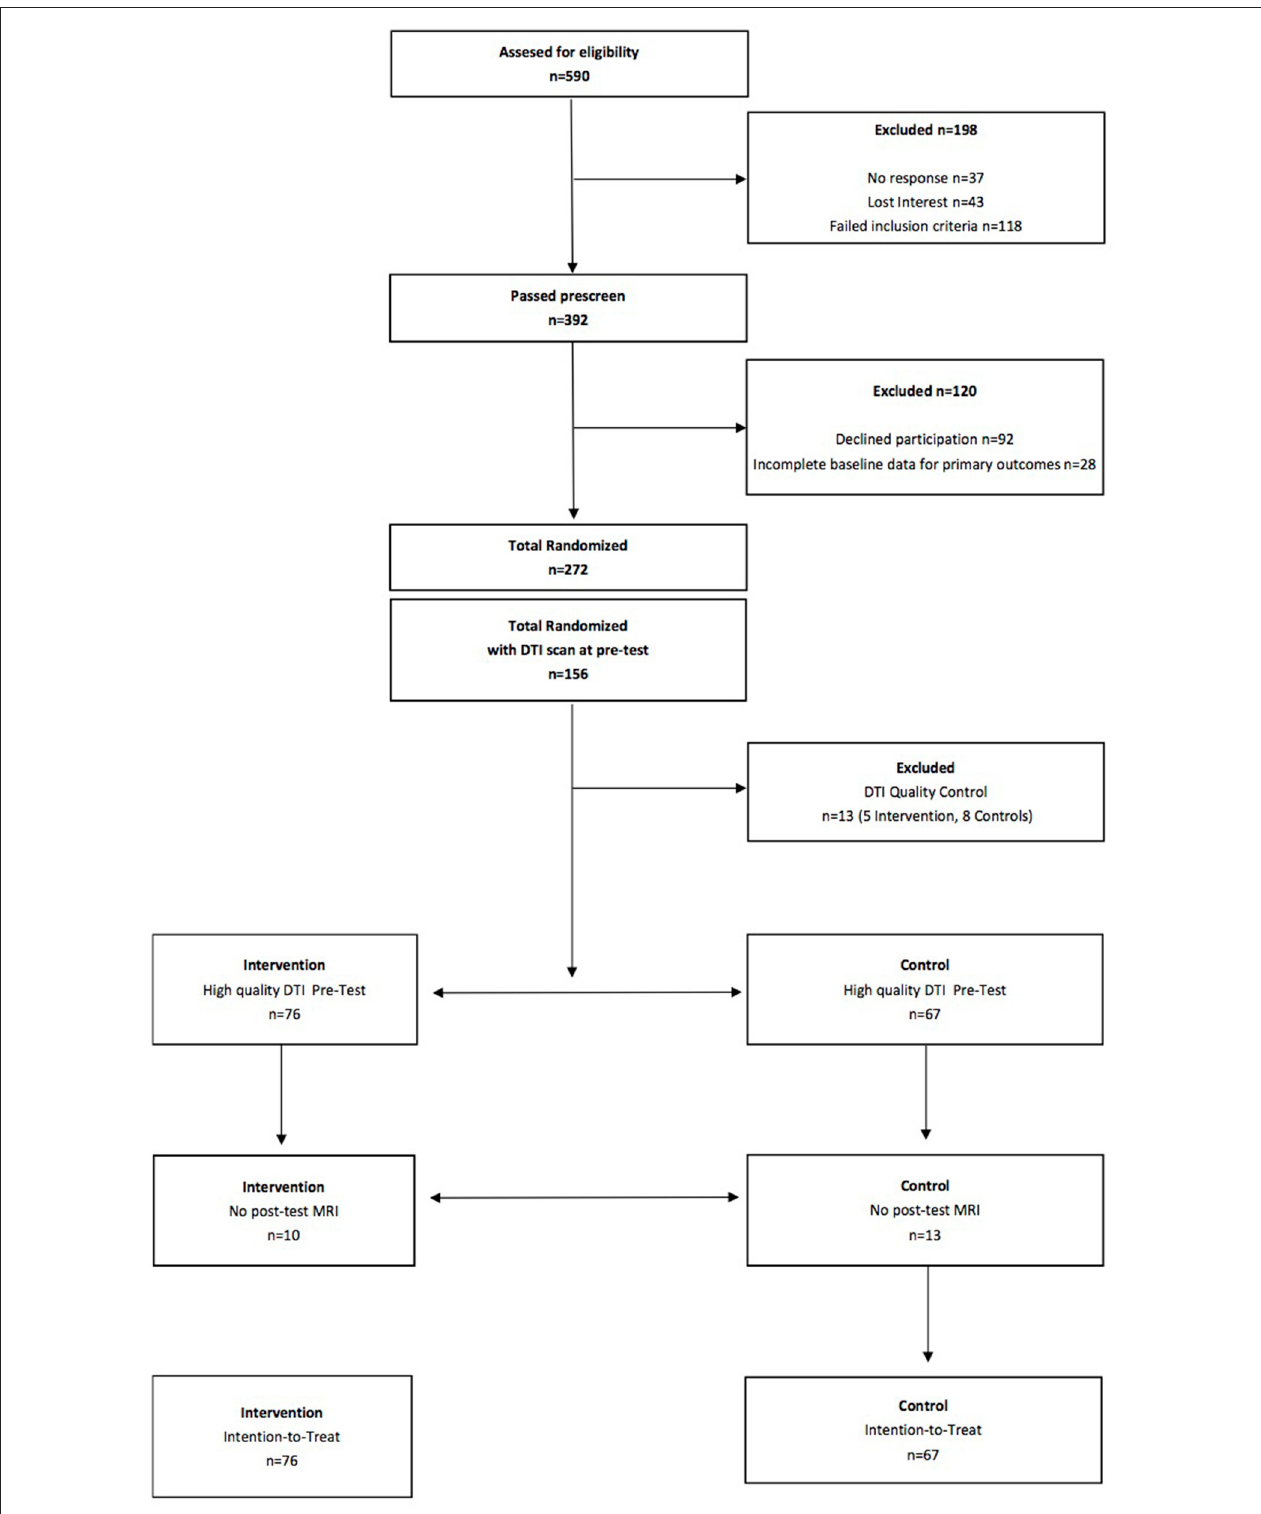
FIGURE 1 | Flow diagram of the FITKids2 DTI